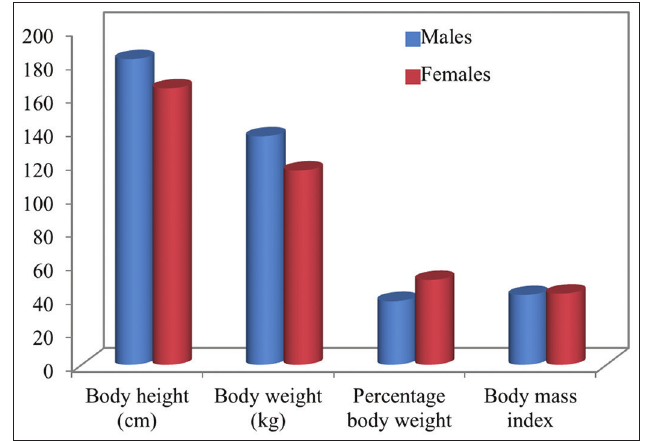
FIGURE 1. Basic anthropometric characteristics of male and female participants on enrollment into the